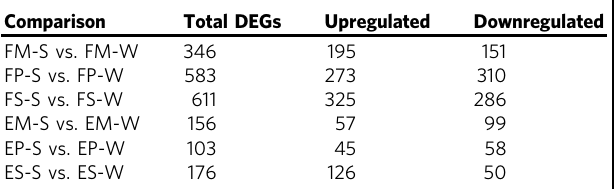
COMMUNICATIONS BIOLOGY| (2021) 4:1170